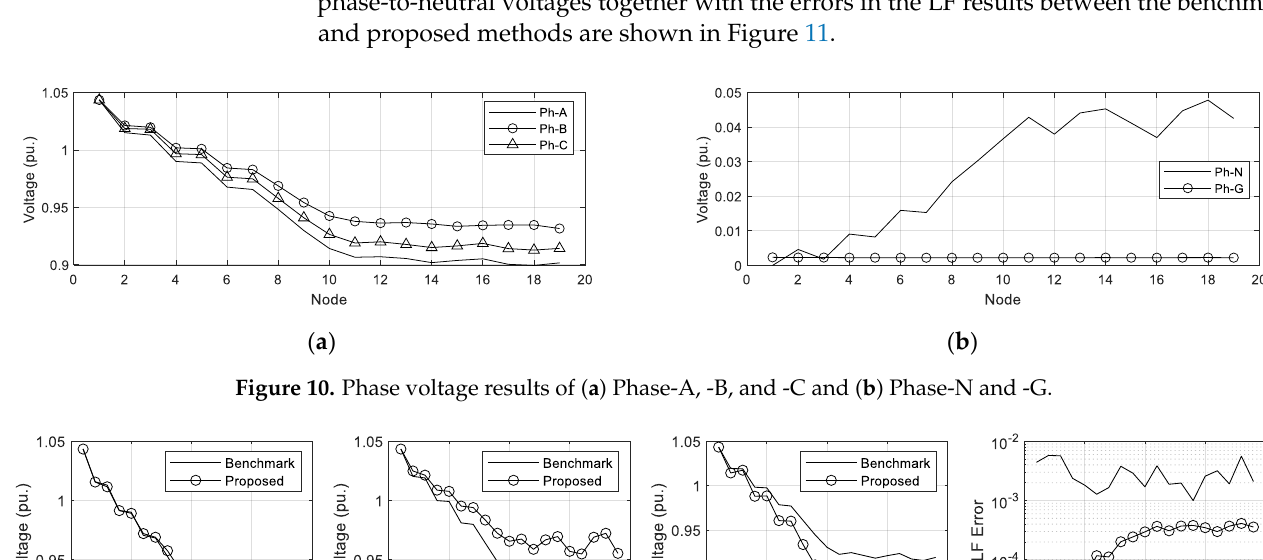
Table 4. The details of PV node.